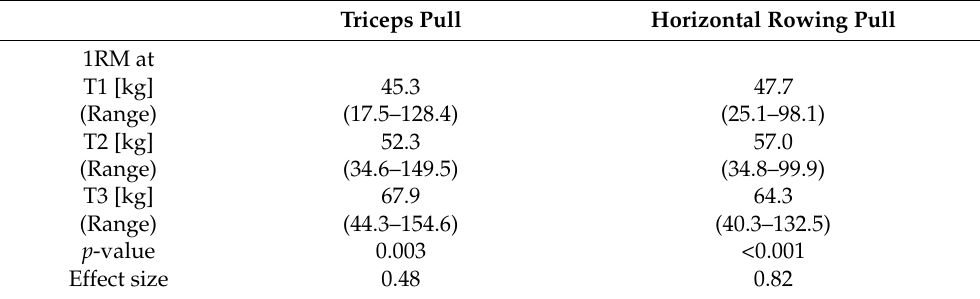
Table 2. Development of the one repetition maximum (1RM) for the triceps and the horizontal rowing pull over the whole strength-training